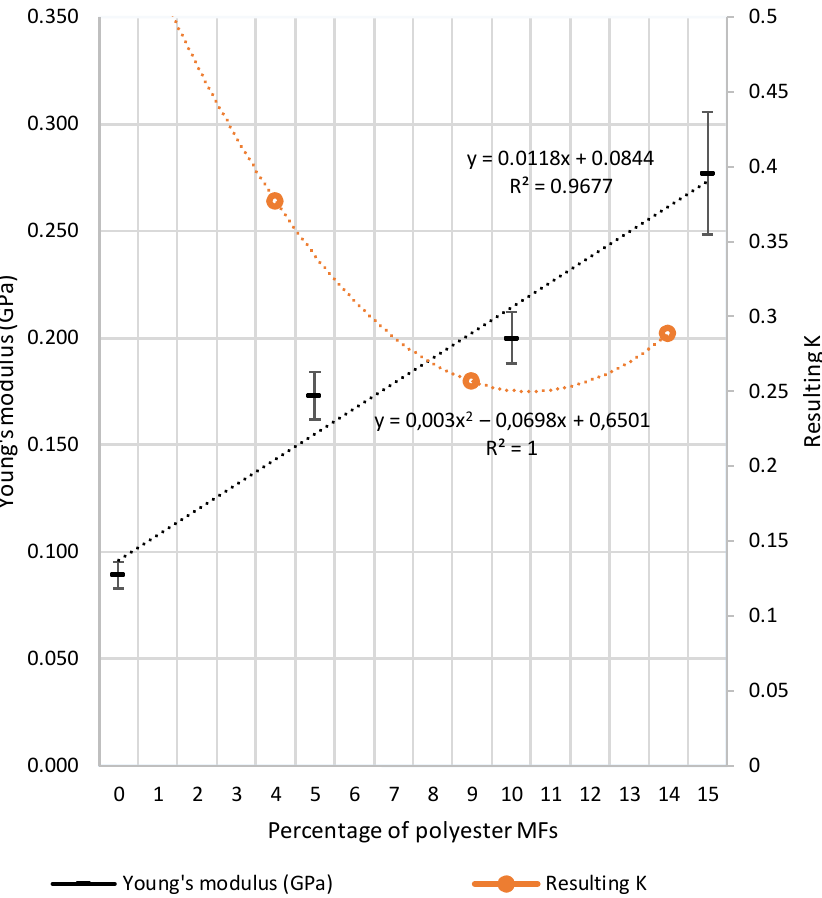
Figure 3. Young’s modulus and the resulting “K” for each of the composites made. It has to be mentioned that what is gained in tensile stress is lost in elasticity. In other words, the composite becomes more prone to rupture without a great deformation. As can be seen in Figure 2, the strain at maximum load decreases when PES-MFs content is increased. Additionally, in Figure 3, the calculated average Young’s modulus is plotted against PES-MFs content, and as can be seen, in all cases, the mean Young’s modulus increases significantly: from 89.2 ± 6.1 MPa for 100% LDPE to 172.8 ± 11.0 MPa, 200.0 ± 11.9 MPa, and 276.9 ± 28.6 MPa for composites with 5%, 10% and 15% PES, respectively. The most plausible explanation for this outcome is that the Young’s modulus of the polyester fibers is much higher than that of LDPE [39]. From our experimental data, the LDPE Young’s modulus is 9 MPa, whereas for PES, the values are between 0.92 and 10 GPa [40– 42]. Hence, the contribution of PES microfibers causes an increase in tensile stress at maximum load compared with pure LDPE.